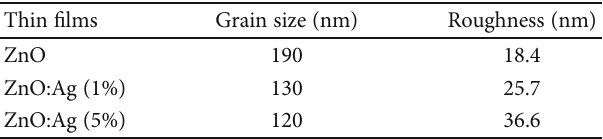
Table 1: Roughness and grain size of TiO fi lms. Thin fi lms Grain size (nm) Roughness (nm)